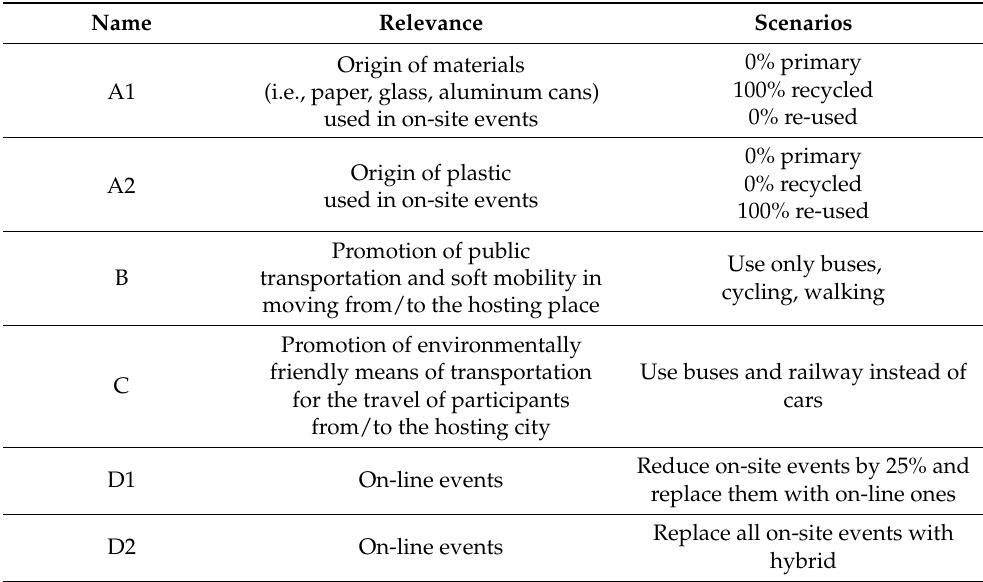
Table 2. Description of the mitigation scenarios related to events organized by the project for reducing the CF of the research